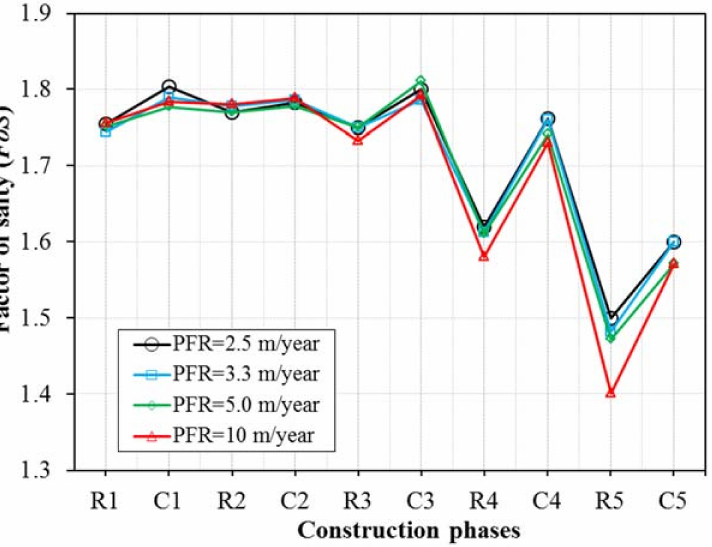
Figure 8. Effect of the pond filling rates ( PFR ) on the stability of the upstream tailings dam (rockfill width of 20